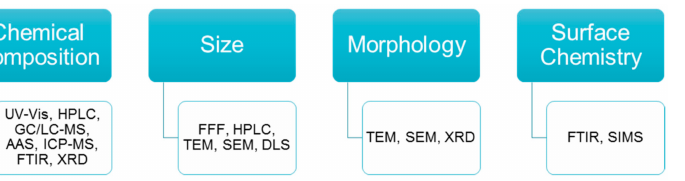
Figure 1. Techniques used for the determination of different parameters of nanomaterials. UV- Vis: Ultraviolet-visible spectroscopy, HPLC: High-performance liquid chromatography,